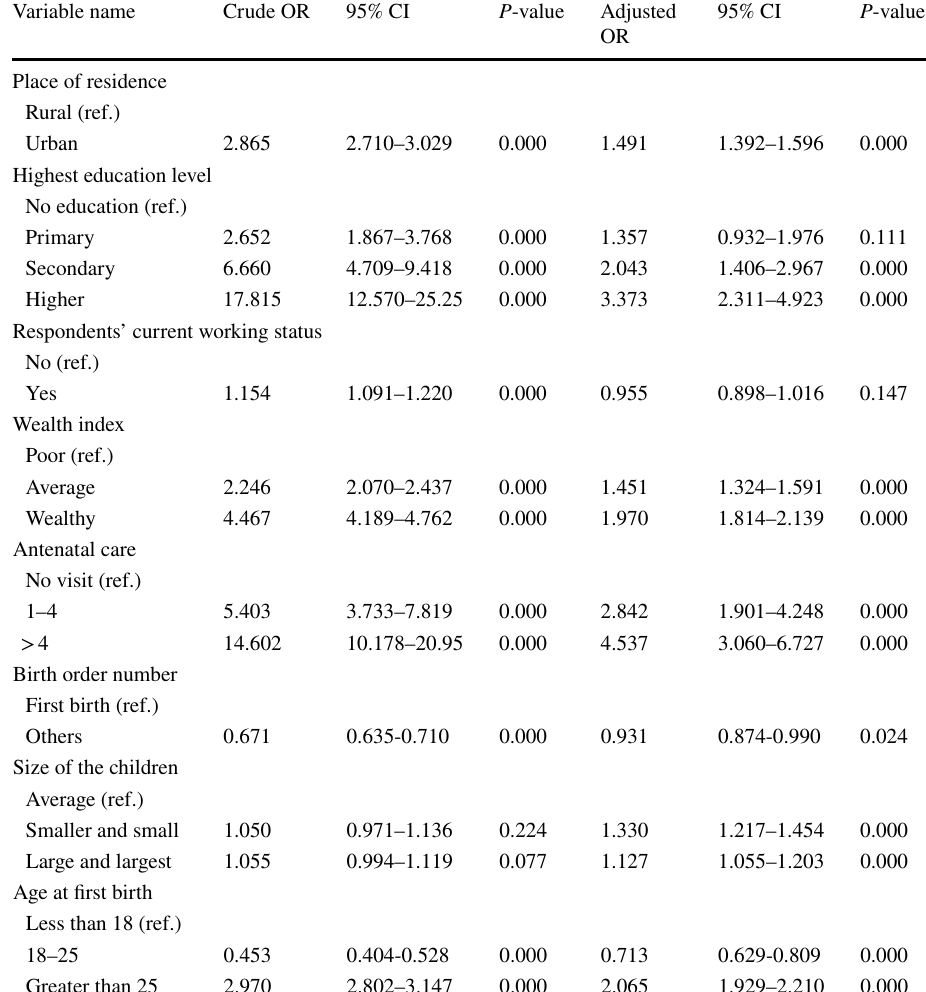
multivariate regression analysis of C-sections according to background characteristics in the combined data from 2007 to